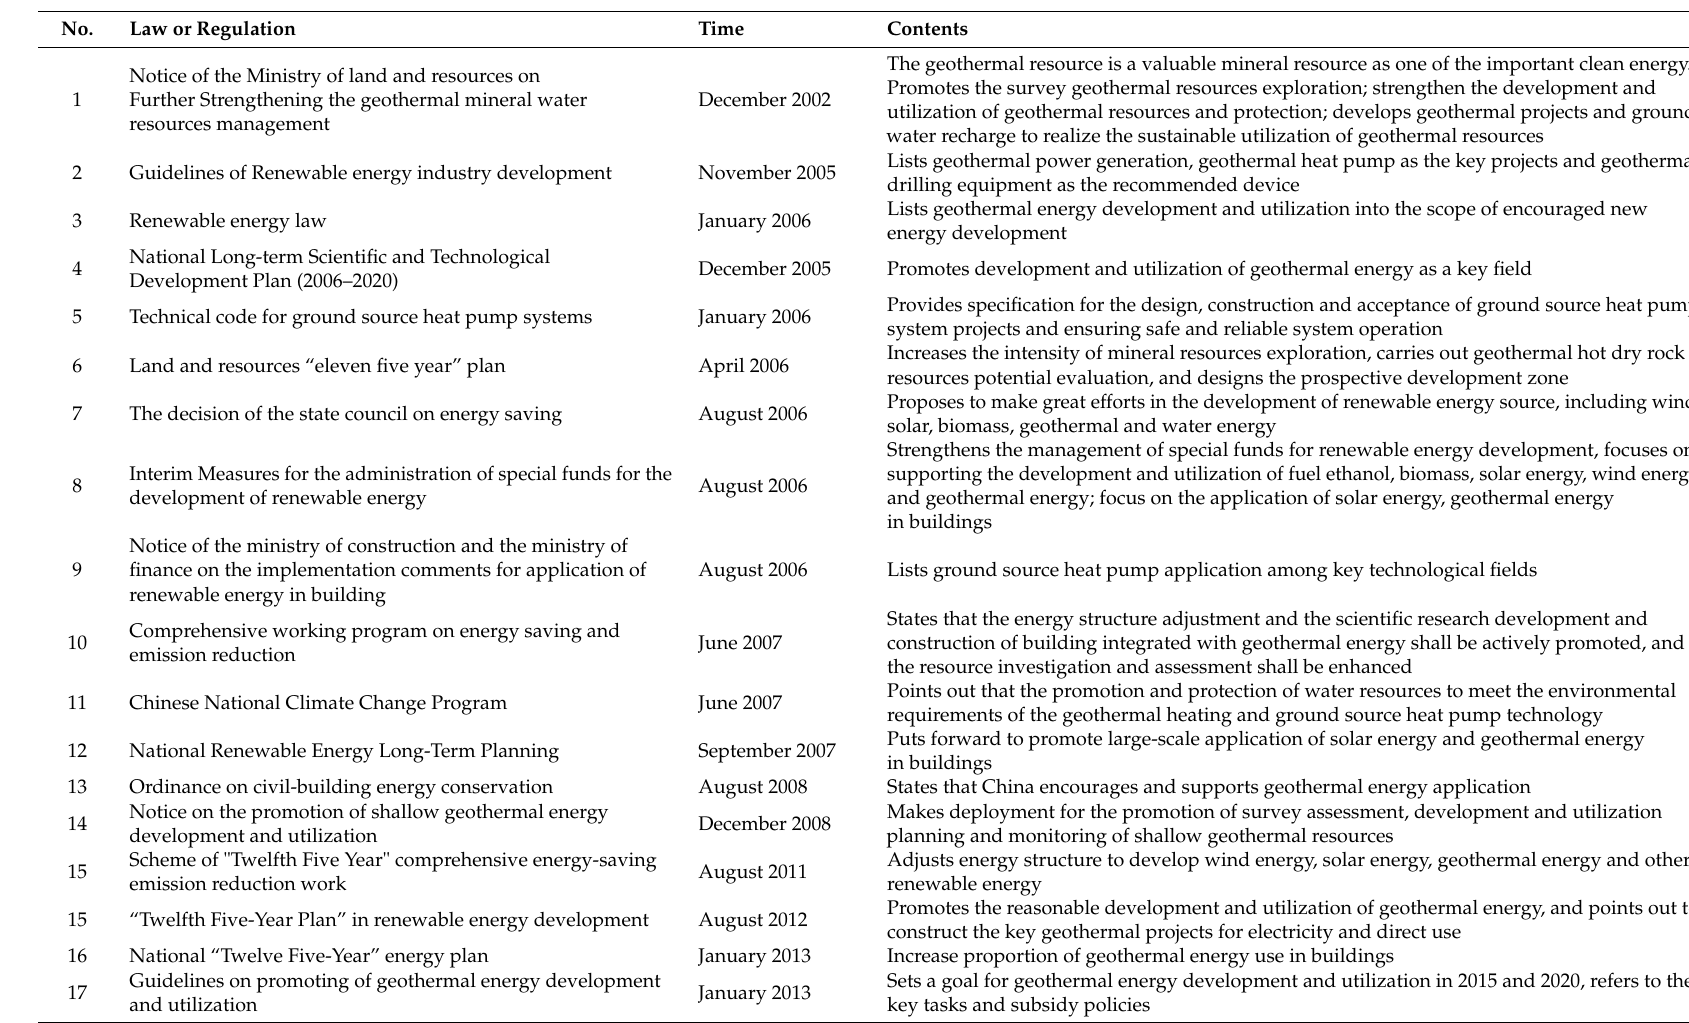
Table 2. Policy and regulations for China’s Geothermal industry